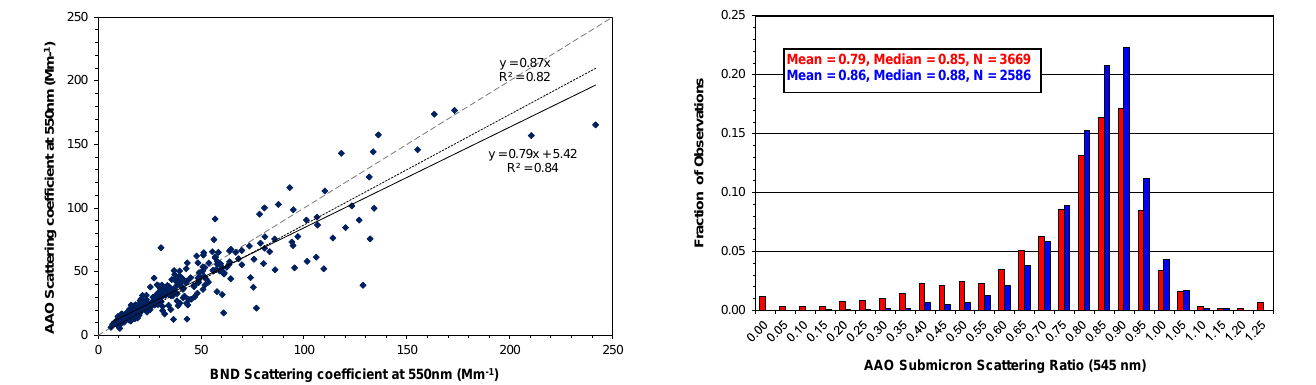
Fig. 12. Comparison of AAO averaged scattering coefficient from the lowest flight level over Bondville with the surface scattering coefficient averaged over the time of each profile.